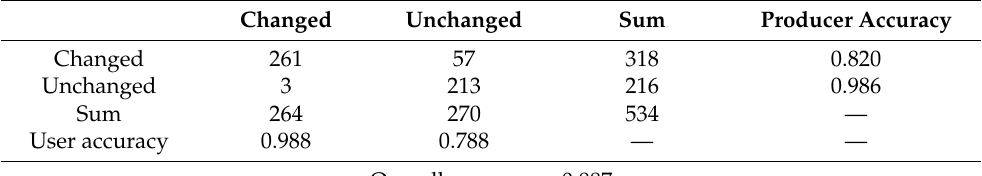
Table 7. Accuracy of Landsat imagery change detection results based on cosegmentation.